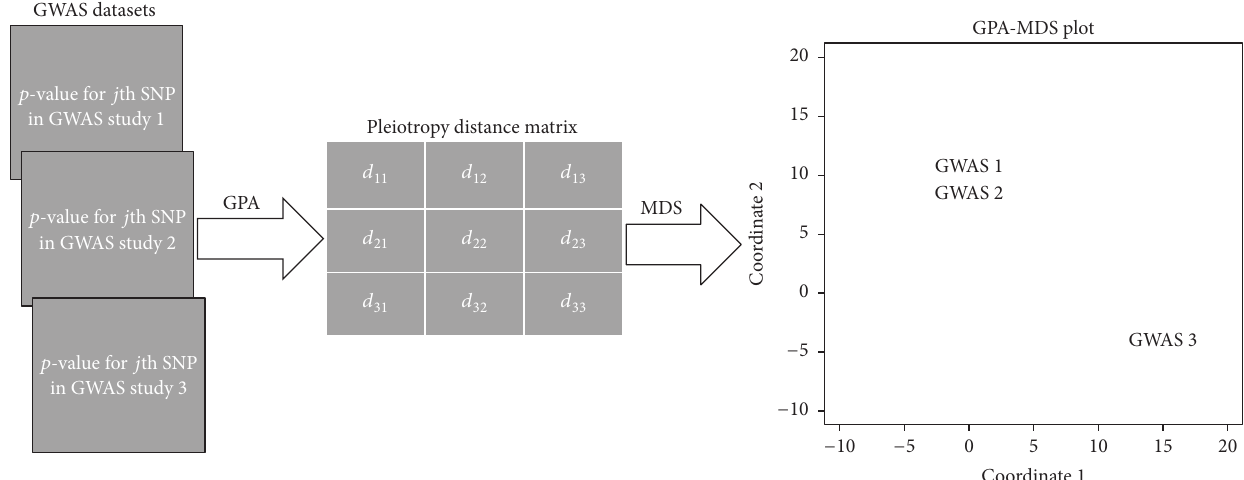
Figure 1: GPA-MDS framework. In this framework, by taking the association 𝑝 -value for each SNP from each GWAS study as an input, we first calculate a distance matrix between phenotypes using the pleiotropy hypothesis testing procedures in the GPA framework. Then, we generate a plot depicting a global picture of genetic relationship among phenotypes by projecting phenotypes onto two-dimensional space using the multidimensional scaling (MDS) algorithm based on this distance